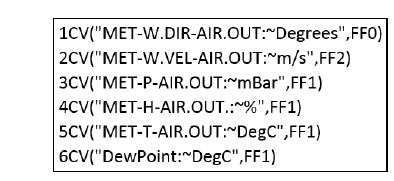
Fig. 8. The analog sensor data acquisition program.